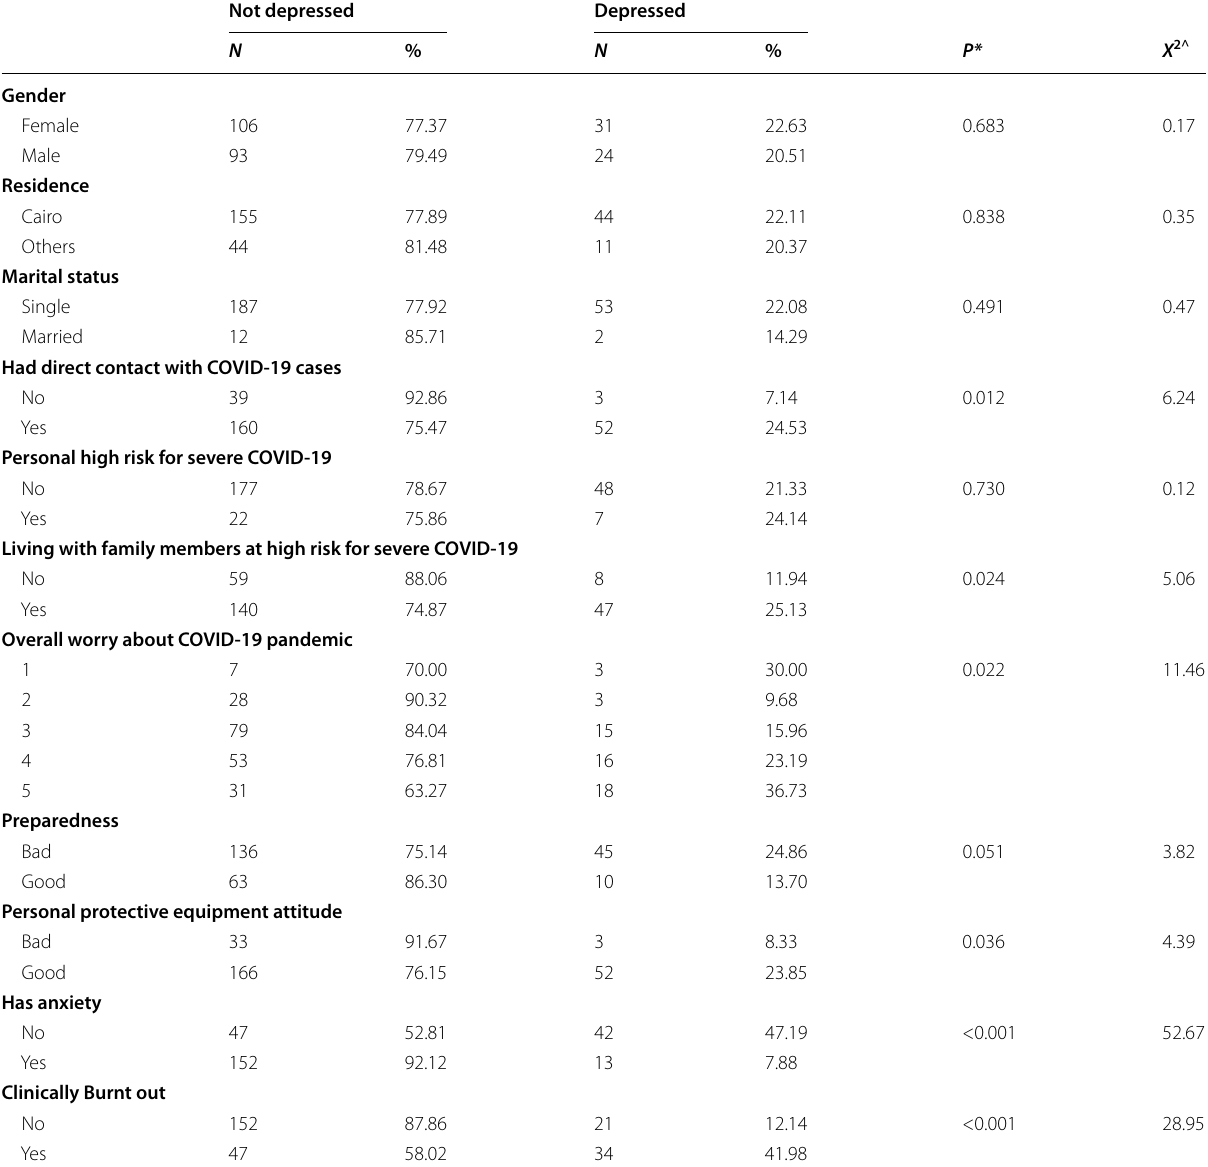
Table 2 Bivariate association between characteristics of the study population and depression ( N